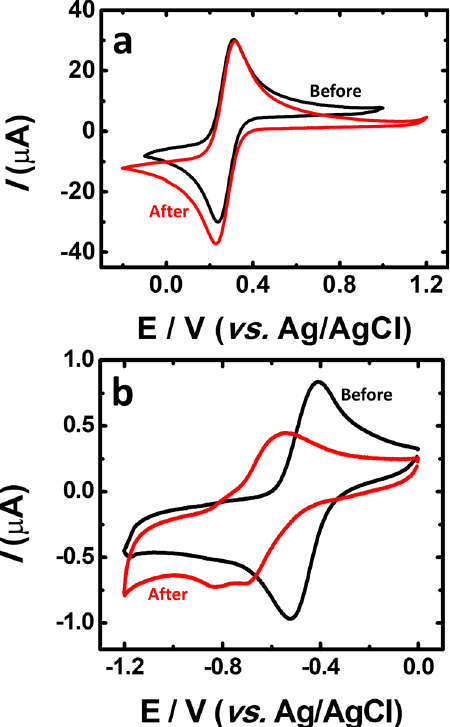
Fig. 9 Cyclic voltammetry curves before and after aqueous all-organic RFB cell test. Comparison between the catholyte (BQDS) ( a ) and anolyte (TRYP-SO 3 H) ( b ) solutions before (black curve) and after (red curve) aqueous organometallic active materials for RFB full cell test using 1.0 M KCl as supporting electrolyte. Solutions with saturated N 2 , υ = 50 mV s − 1 .